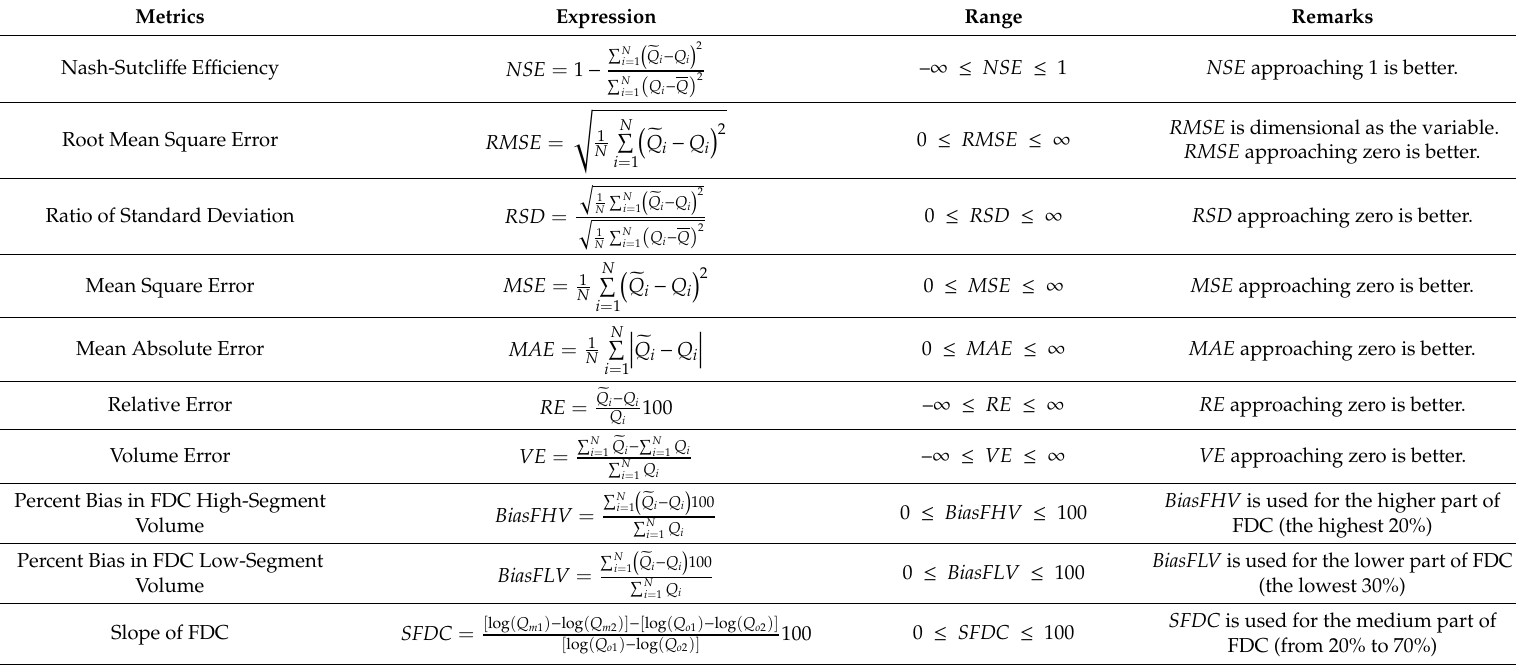
Table 1. Performance metrics [36,37].